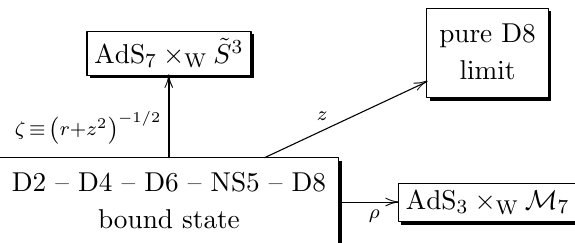
Figure 2 . The three di(cid:11)erent limits of the brane system represented in (4.1) depending on the three coordinates ( (cid:26); z; r ), respectively yielding AdS 7 , the asymptotic domain-wall behavior typical of massive type IIA solutions, and AdS 3 . Each limit is controlled by a di(cid:11)erent combination of the above